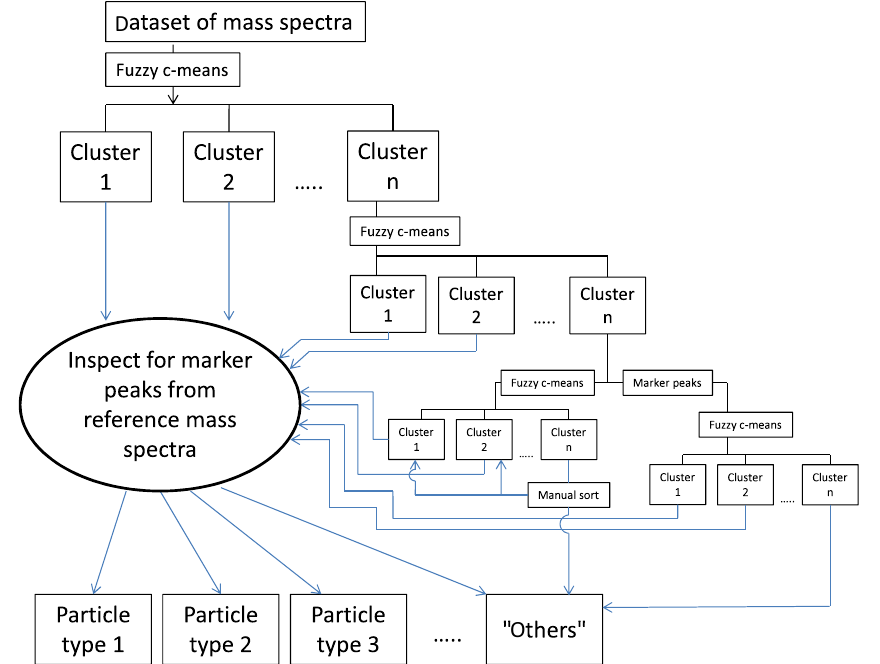
Figure 1. Flow chart of the single particle mass spectra evaluation. Each cluster that was found by the fuzzy c -means algorithm was manually inspected for marker peaks and assigned to the appropriate particle type. This procedure was repeated with the group of mass spectra (cluster n ) that did not meet the distance criterion in the first clustering run. Eventually the remaining mass spectra were manually sorted and inspected for marker